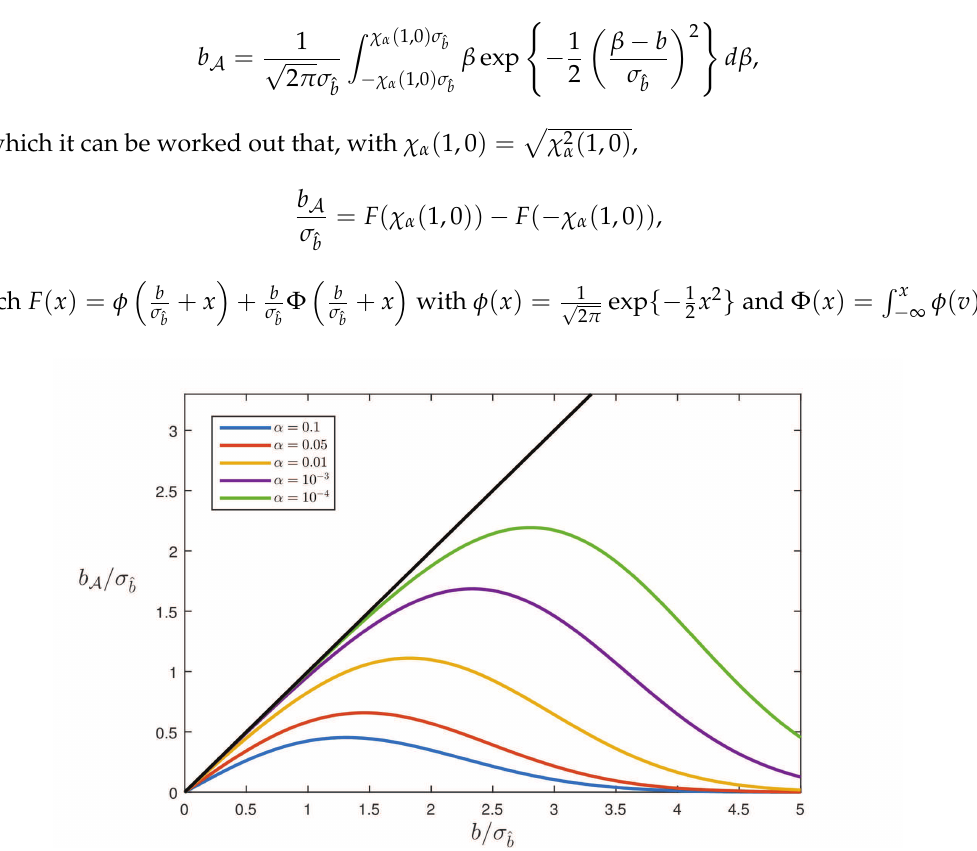
as function of b / σ ˆ b